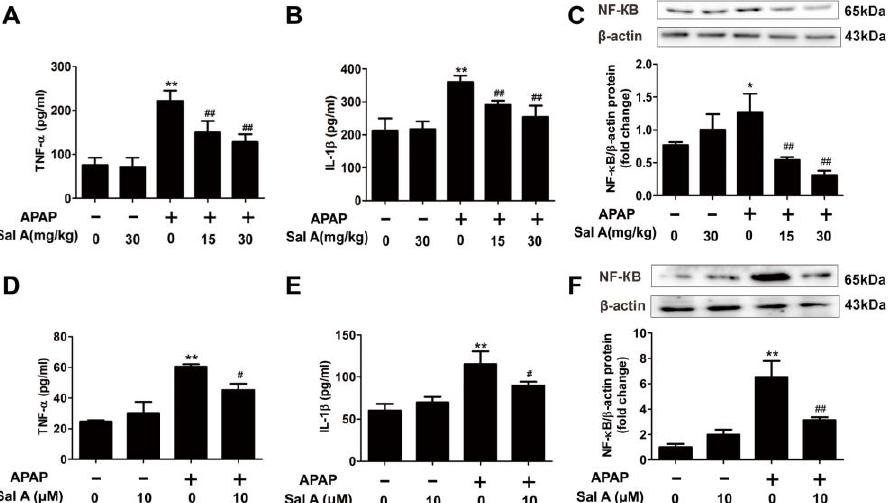
Figure 3. Sal A ameliorates inflammation in vivo and in vitro. ( A – C ) Sal A pretreatment for 3 days followed by APAP stimulation in mice. ( A , B ) Serum TNF- α and IL-1 β levels were determined by ELISA, n = 8. ( C ) The protein level of NF- κ B in mice, n = 3. ( D – F ) AML12 cells were incubated with Sal A before exposure to APAP. ( D , E ) TNF- α and IL-1 β levels were determined by ELISA, n = 8. ( F ) The protein levels of NF- κ B in AML12 cells, n = 3. * p < 0.05, ** p < 0.01 vs. control. # p < 0.05, ## p < 0.01 vs. APAP.